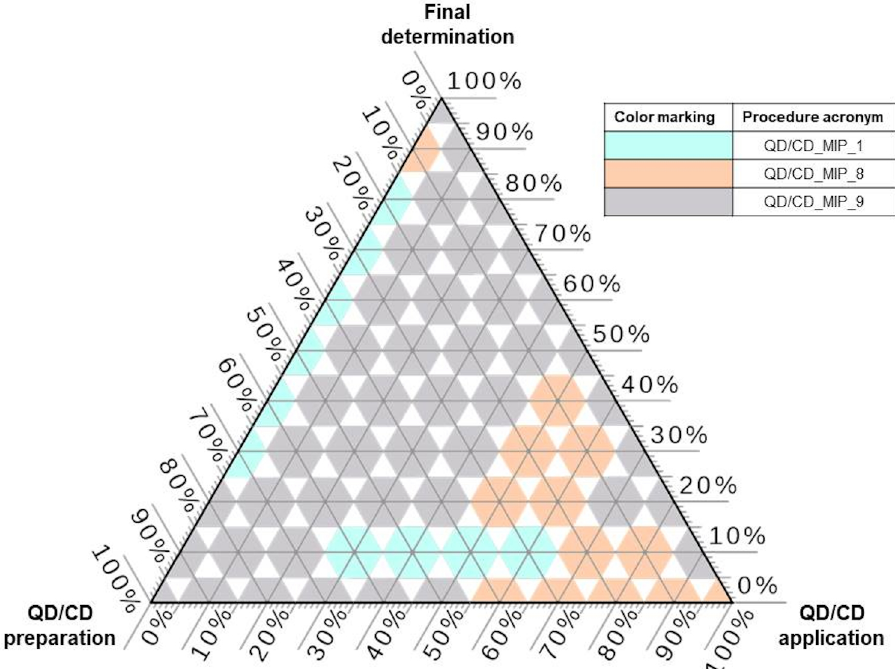
Figure 8. The winning procedures based on quantum or carbon dots application, according to TOPSIS rankings for different weights